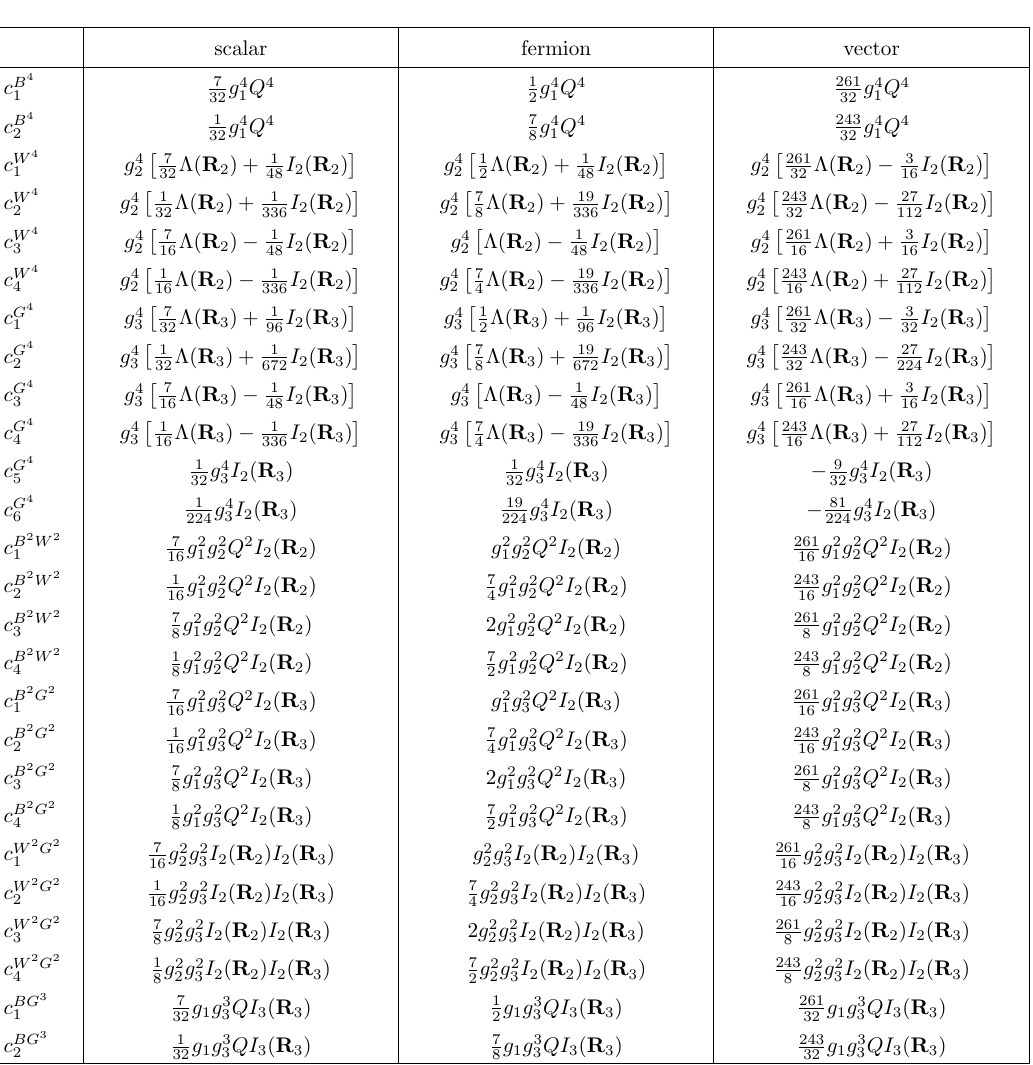
Table 5 . Wilson coe(cid:14)cients, from ref. [109], for the generalized Euler-Heisenberg operators in table 1 generated by integrating out a massive complex scalar, Dirac fermion, or complex vector charged under the SM gauge group as described in text. All c i have been multiplied by 6! (cid:25) 2 , and all c i not given in this table vanish at one loop for these completions.